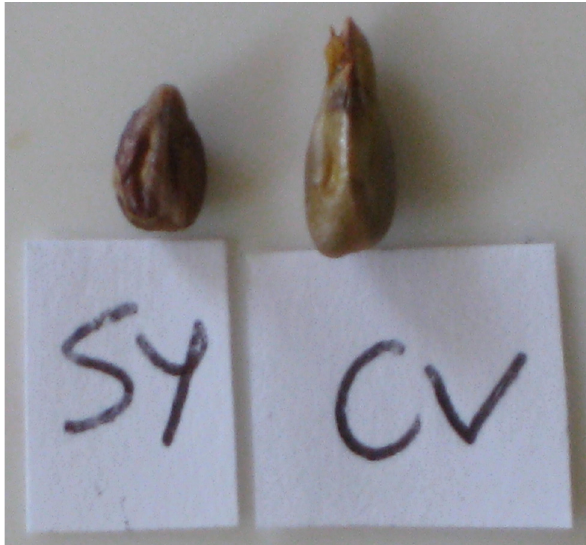
Fig. 2. Comparison of seeds of sylvestris (sy) and grape